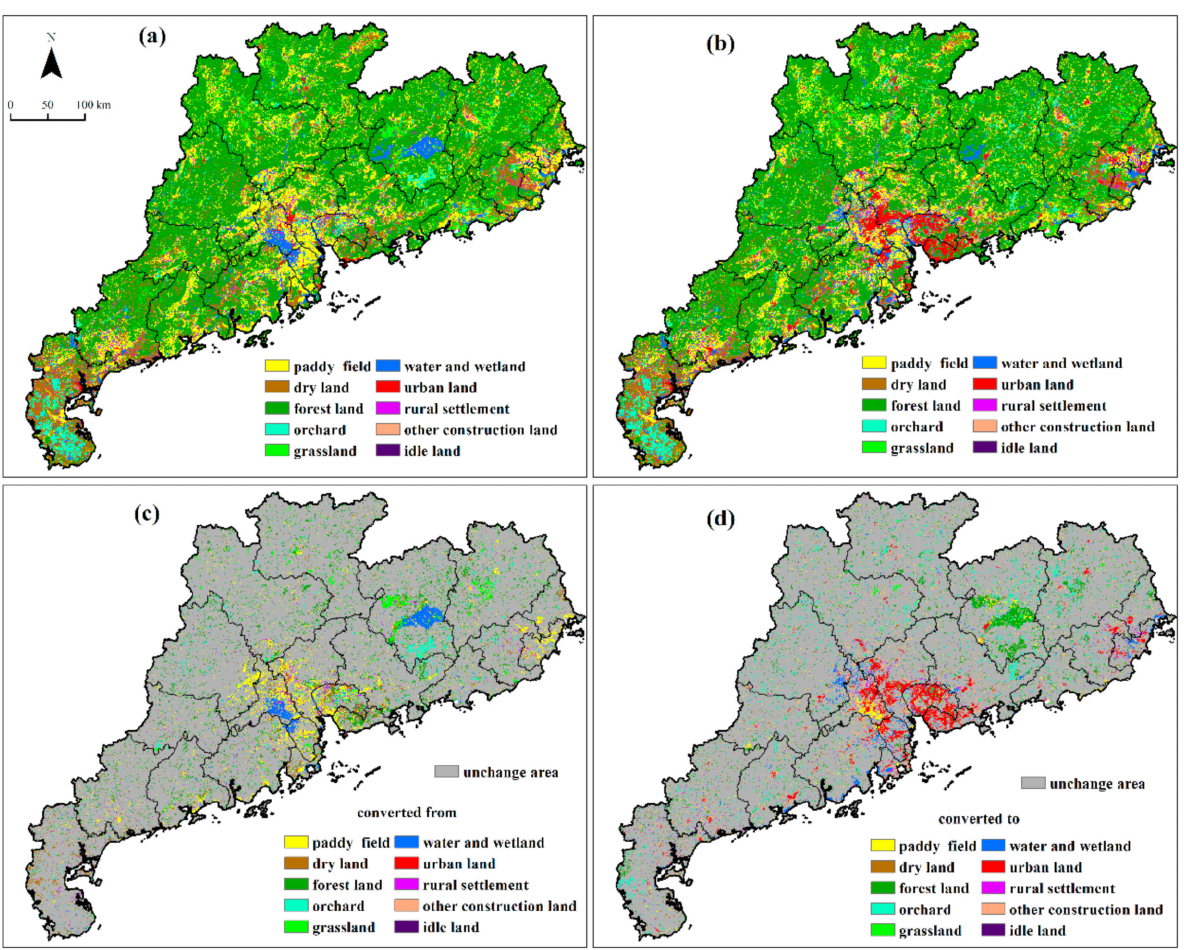
Figure 4. Land use spatial distribution in 1980 ( a ) and 2020 ( b ) and land use converted in ( c ) and out ( d ) from 1980 to